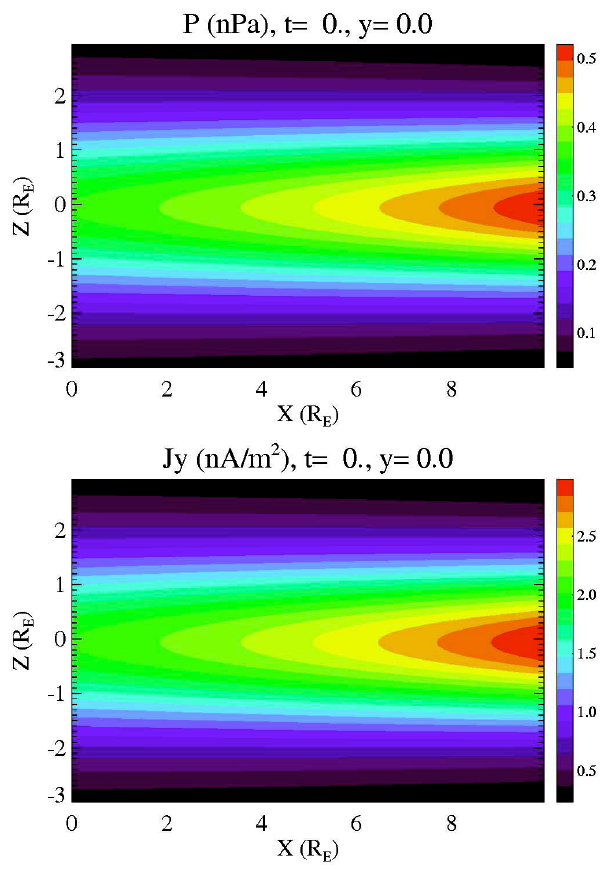
Fig. 5. Contours of pressure (top) and cross-tail current (bottom) for the equilibrium model described in Eqs. (2) and (3). Note that the pressure contours are equivalent to magnetic field